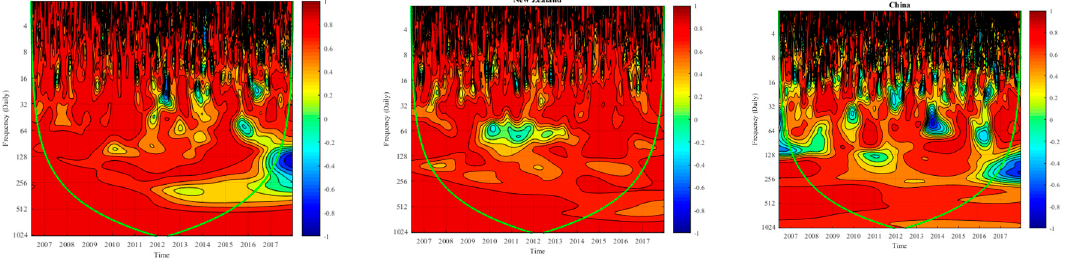
Figure 1. Asia/Pacific region’s Islamic-conventional stock returns wavelet correlations.